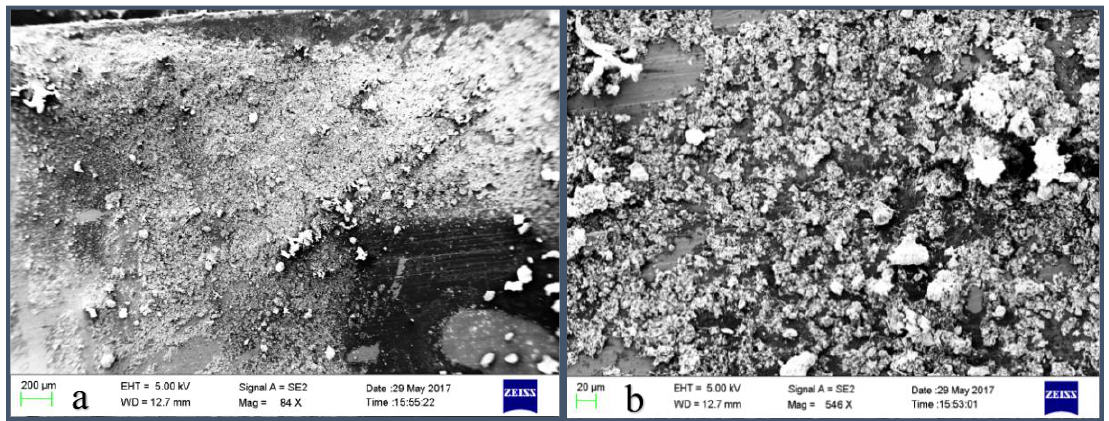
Figure 2. ( a – b ) SEM images of Mn:ZnS QDs. Figure 2. ( a , b ) SEM images of Mn:ZnS